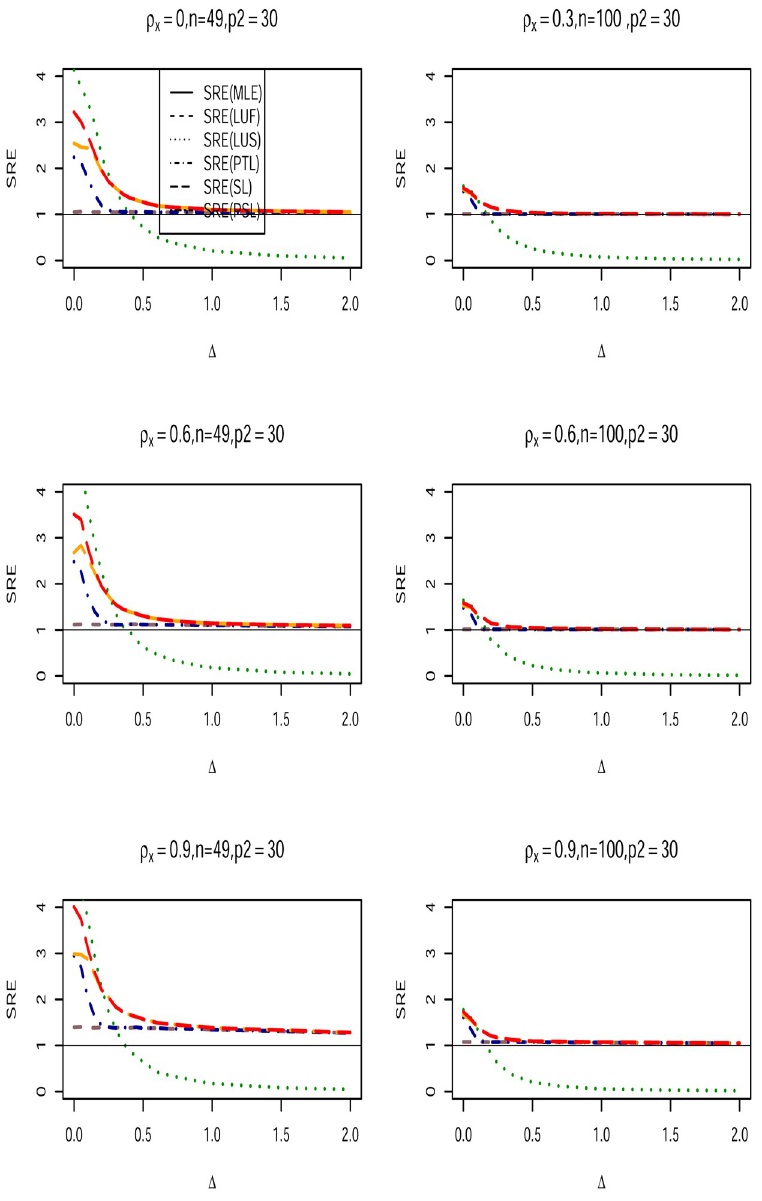
Fig 3. SRE of the proposed estimators with respect to ( ^ β p 2 ) = (5,